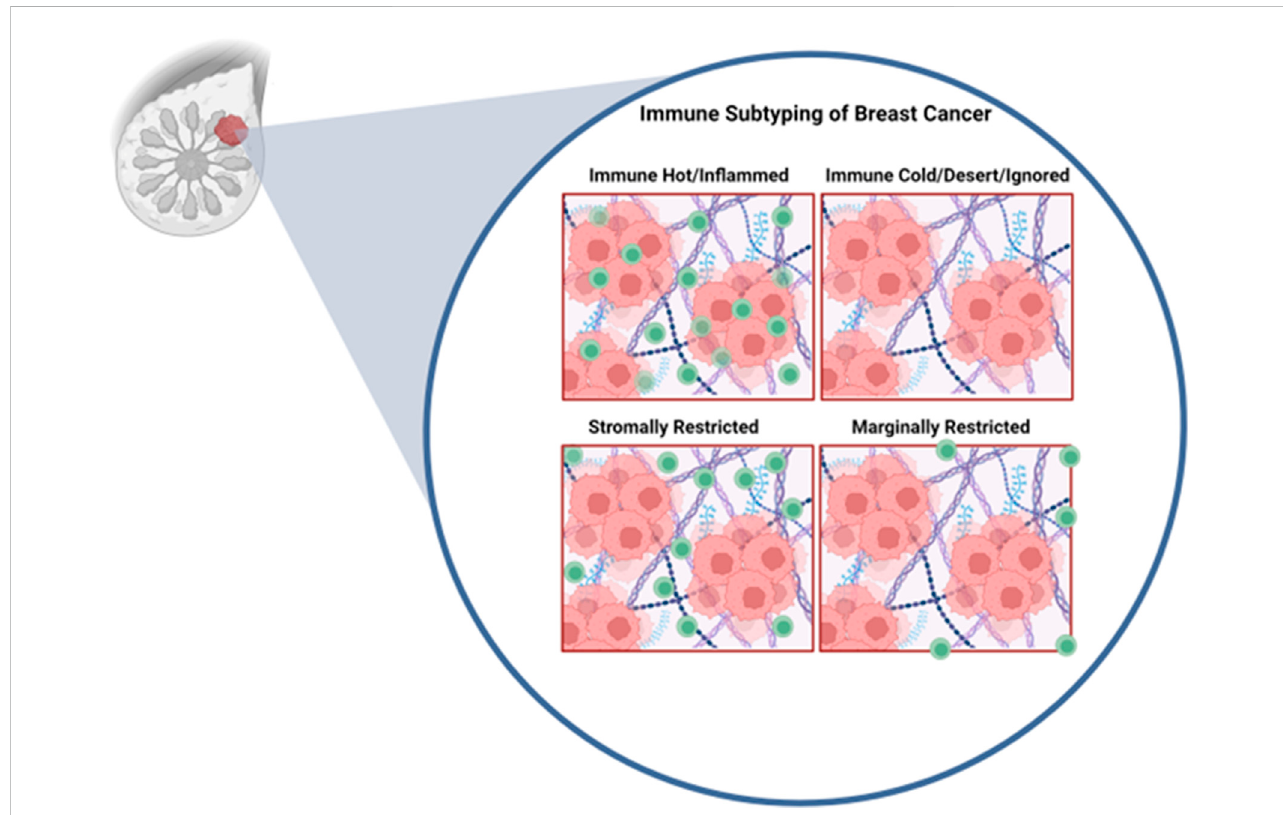
FIGURE 2 Immunepro fi lesofbreastcancer.InspiredbyGrussoetal.Intheimmunehotsubtype,cytotoxicT-cellsareabletofullyin fi ltratethetumor.Immunecold tumors are fully devoid of cytotoxic T-cells. Stromally restricted tumors are in fi ltrated by T-cells only in the stroma but not tumor nest. Marginally rrestricted tumors have T-cells limited to the tumor margin and not capable to reaching the tumor nest. Figure generated with